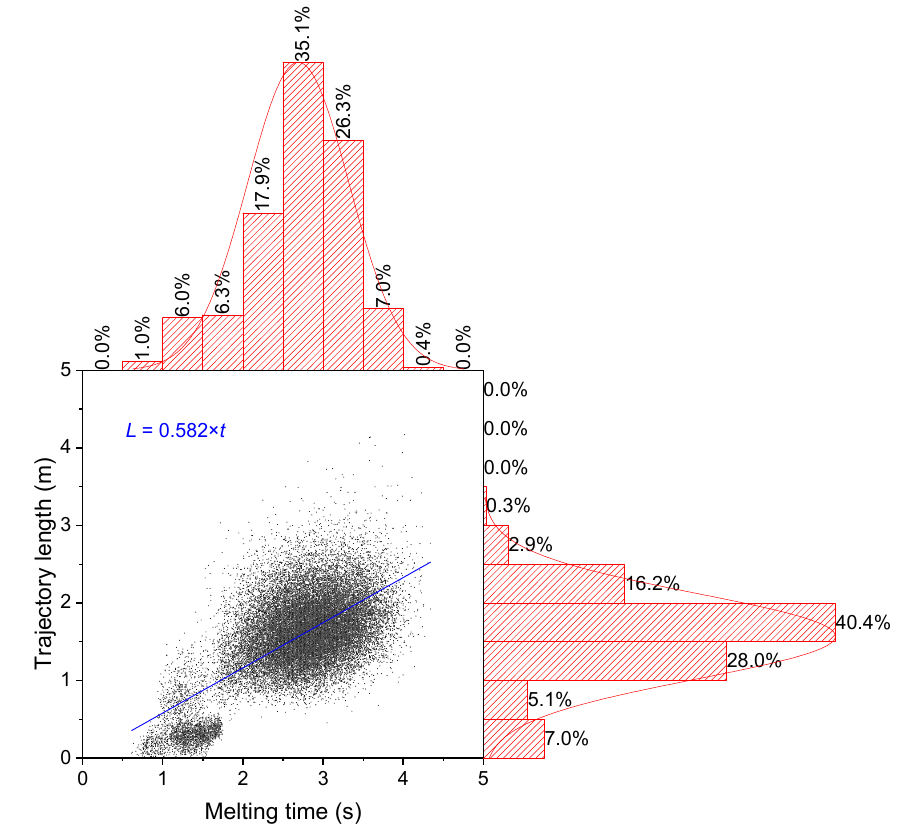
Figure 4. Melting time and trajectory length of aluminum particles.